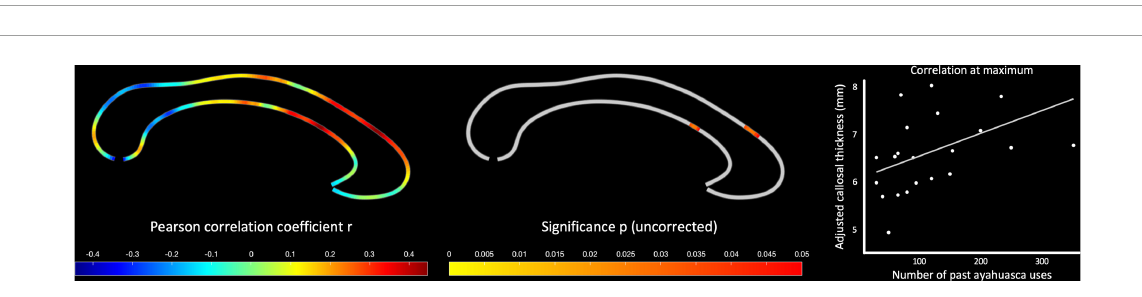
FIGURE2 Positive correlations between callosal thickness and ayahuasca use. The color bar encodes the Pearson correlation coefficient (r) on the left , and the uncorrected significance (p) in the middle . The scatterplot on the right illustrates the association between the number of ayahuasca uses and callosal thickness at the maximum of the significance cluster, adjusted for age and total intracranial volume